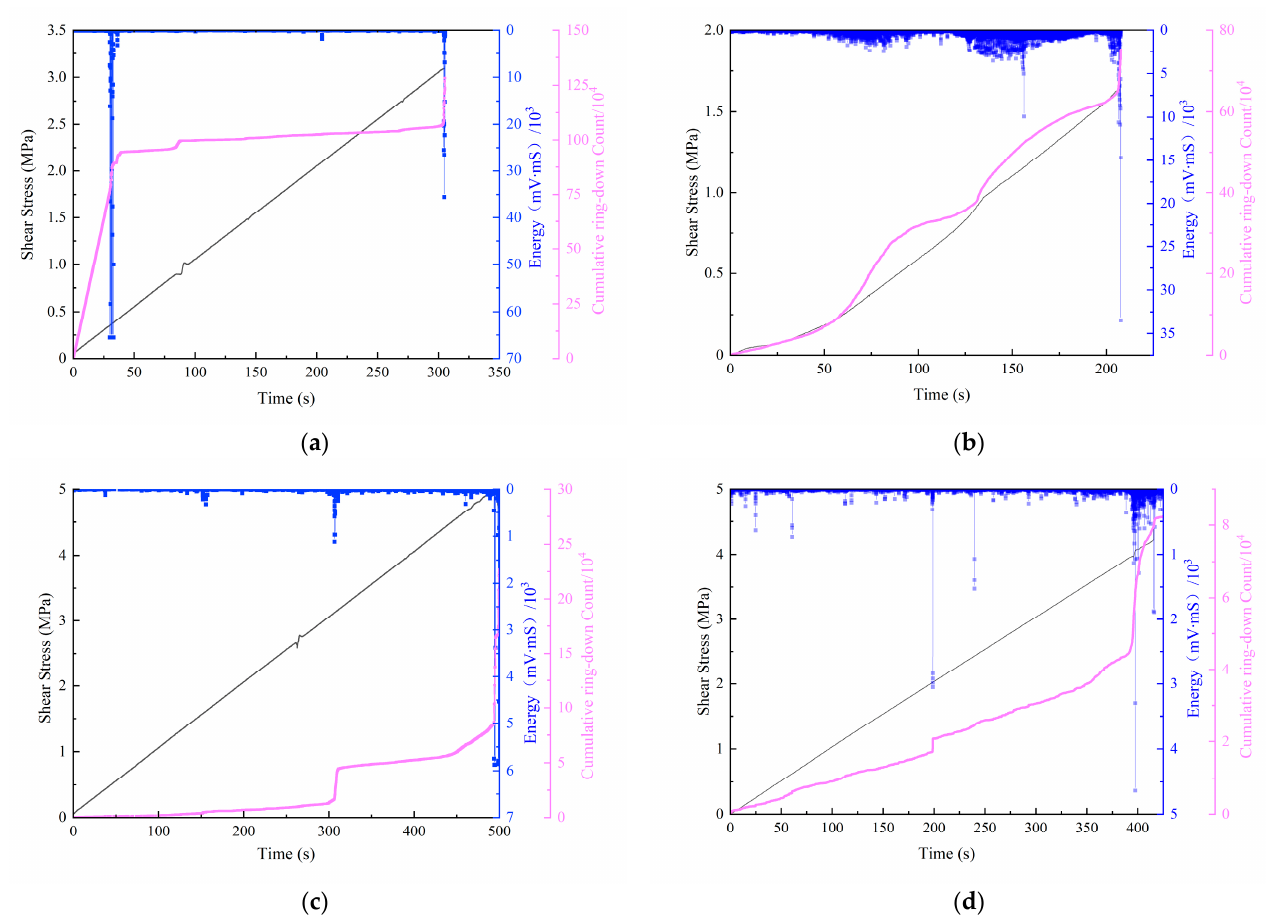
Figure 8. Shear load, AE cumulative ring-down count and energy with time under different normal loads. ( a ) Under 10 kN constant normal load. ( b ) Under 10 kN dynamic normal load. ( c ) Under 50 kN constant normal load. ( d ) Under 50 kN dynamic normal load.